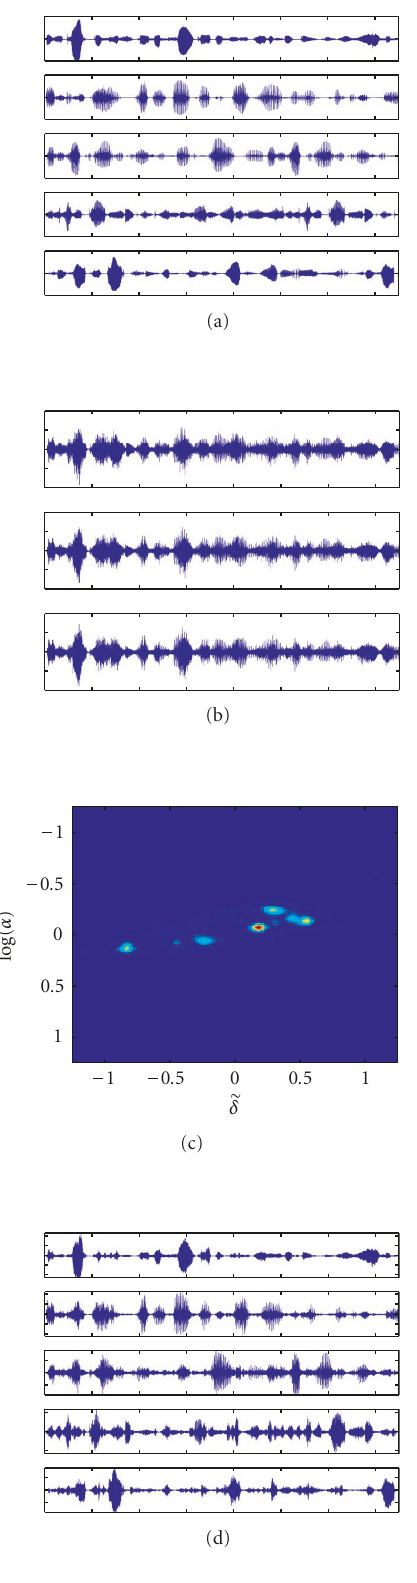
Figure 3: Undetermined blind source separation via hard DE- SPRIT: (a) 5 speech sources, (b) 3 anechoic mixtures from a uni- form linear array, (c) the 2-dimensional power weighted histogram shows 5 peaks from which (d) 5 demixtures are